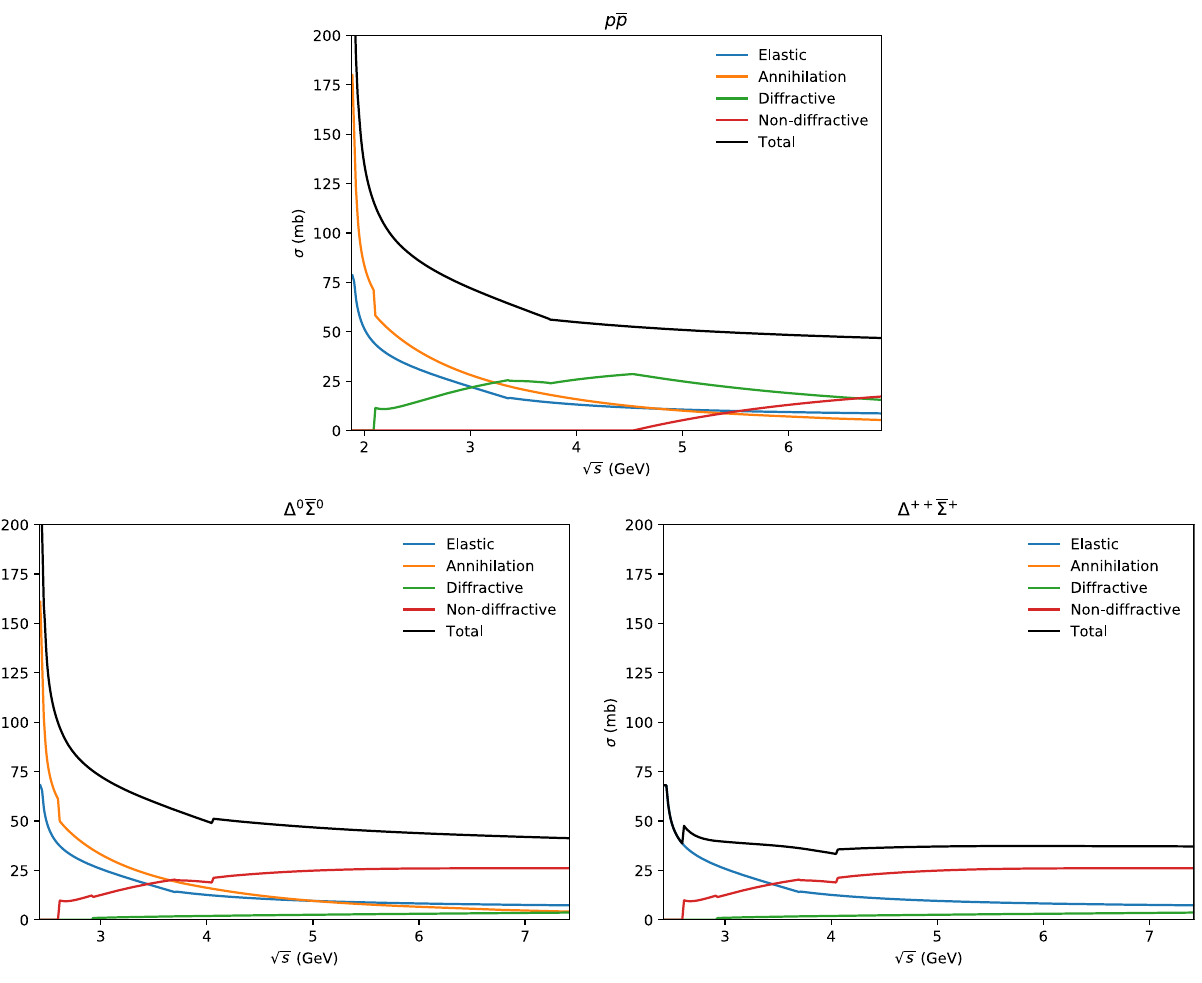
+ + resonances. For Δ ++ Σ . We see that annihilation is not possible, so the annihila- tion cross section is subtracted from the total, significantly changing its